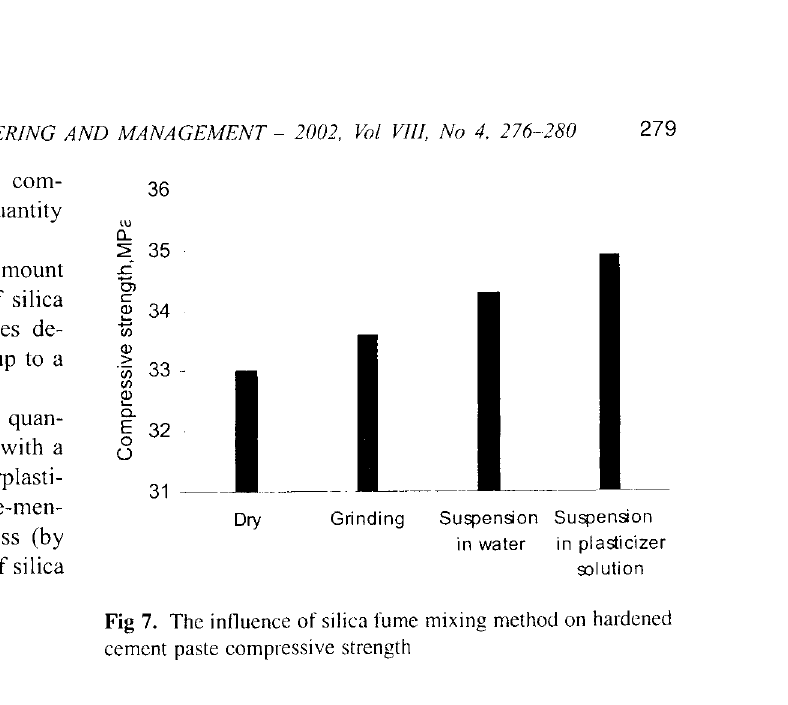
Fig 7. The influence of silica fume mixing method on hardened cement paste compressive strength aldehyde or melamine formaldehyde superplasticizers, plasticizers on lignosulfonates base and silica fume. Naphthalene formaldehyde superplasticizer